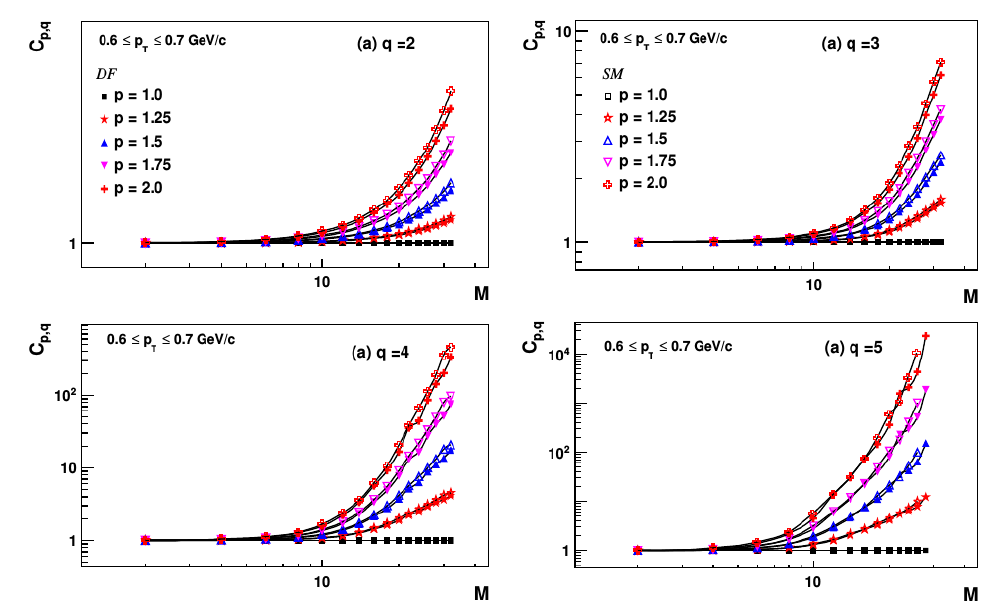
Figure 7. Analysis of moments in intermittency study for the p ⊥ window 0.6 ≤ p ⊥ ≤ 0.7GeV, cf. ref. [90].